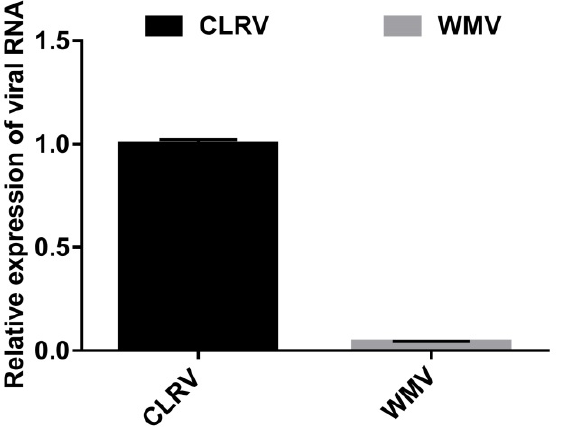
Figure 6. Quantitative RT-PCR analysis of the RNA accumulation of watermelon mosaic virus (WMV) and cotton leaf roll virus (CLRV). The expression of UBQ7 was used as a reference control. The accumulation of CLRV and WMV RNA is represented relative to UBQ7 using the comparative Ct method (2 −ΔΔ Ct ). The expression of CLRV was set as 1. Error bars represent the standard deviation of each data set.